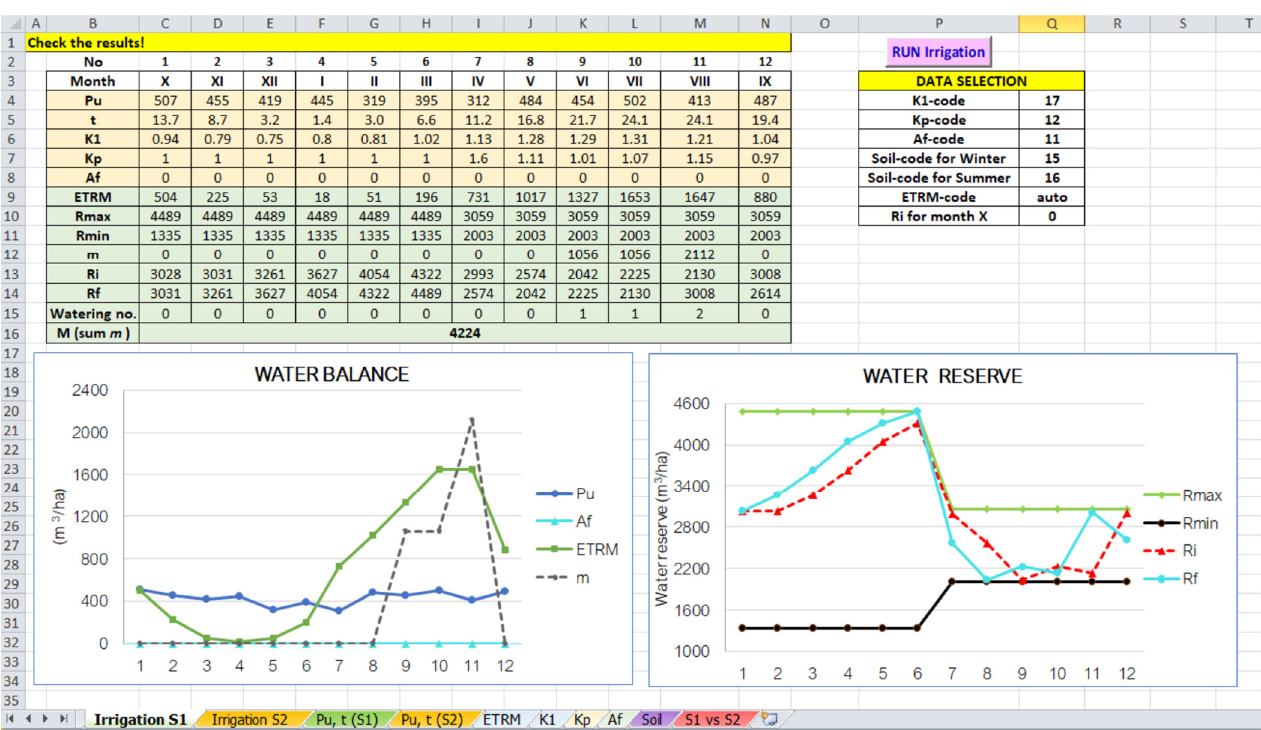
Figure 16. Output of running the algorithm using ETRM recorded at Mamaia (5 km from CT).